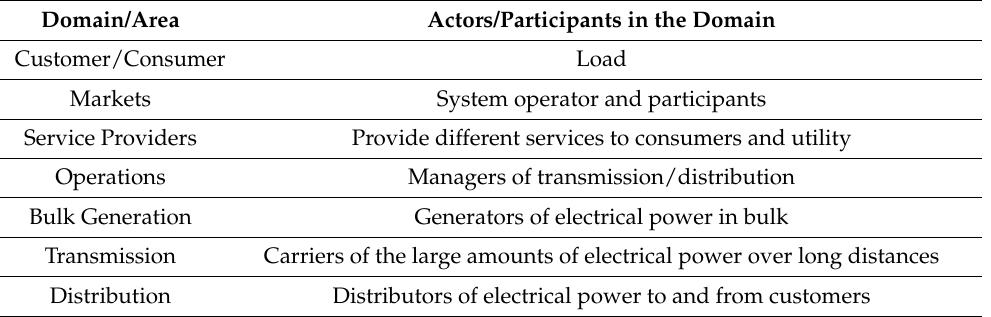
Table 2. Domains and actors in the NIST SG model [42].